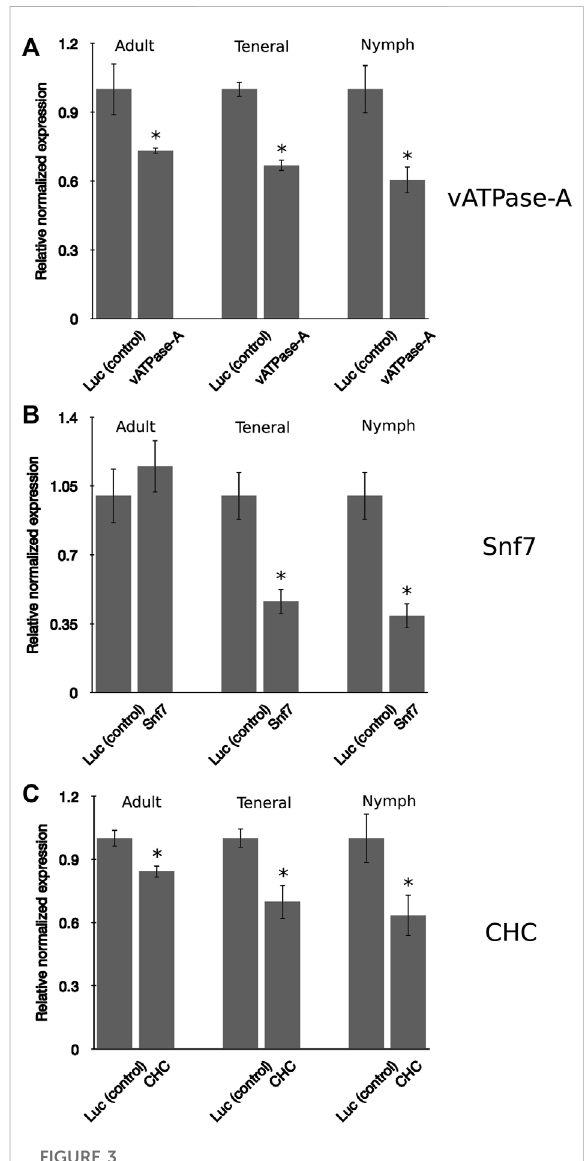
FIGURE 3 Comparison of gene knockdown levels across the developmental stages in potato psyllid (A – C) . Relative normalized expression of vATPase-A subunit (A) , Snf7 (B) ,